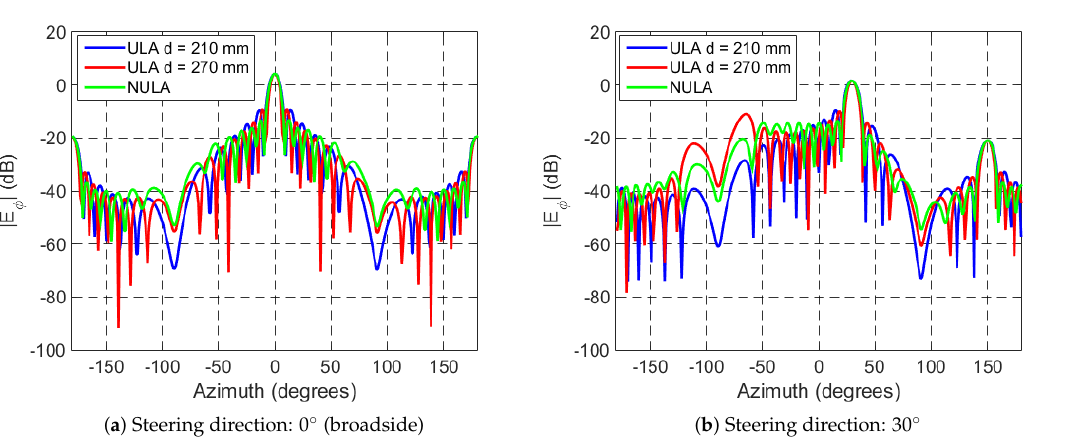
Figure 12. Azimuth plane radiation patterns of the ULAs ( d = 210 mm and 270 mm) and NULA, with 11 Televes 4G NOVA antennas without the radome or reflector, for 770